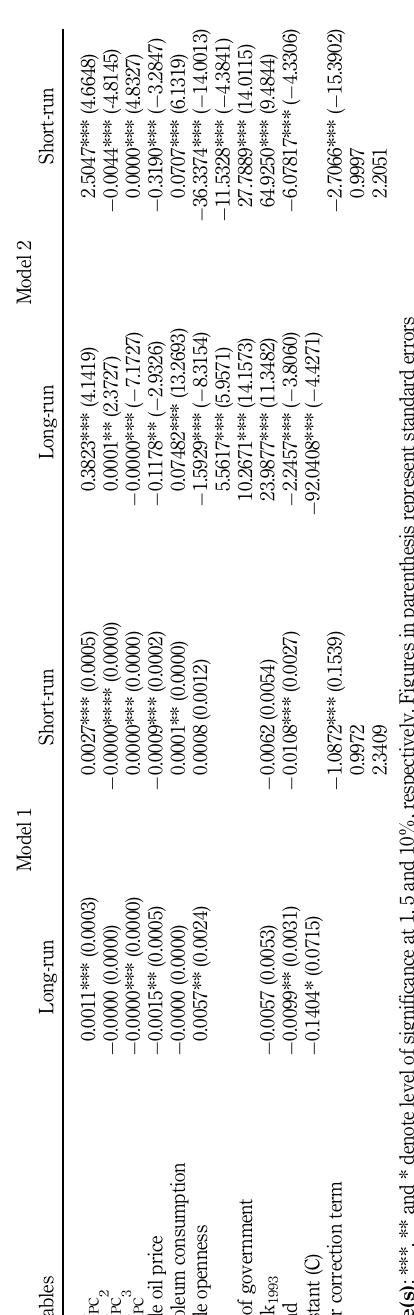
Table 3. Estimation of EKC models for